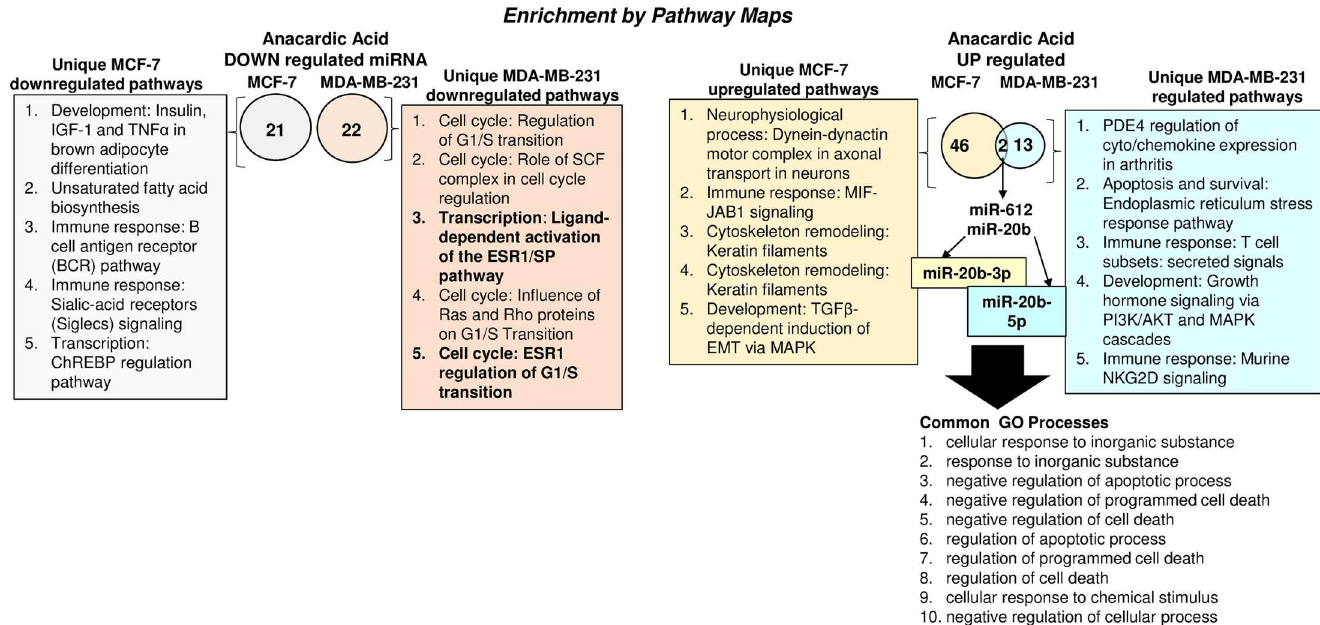
Fig 2. Enrichment analysis of miRNA-seq data. Differentially expressedgeneswere identifiedin pairwisecomparisons: MCF-7 AnAc vs. MDA-MB-231 AnAc using the tuxedo suite of programs includingcufflink-cuffdiff2. The Venn diagrams show the number of common and differentiallyexpressedgenes significantly downregulated(A) and upregulated(B). Pathway analysiswas performed using GeneGo Pathways Software (MetaCoreTM). The pathways identified for each comparisonare listed in the order provided by MetaCoreTM analysis.